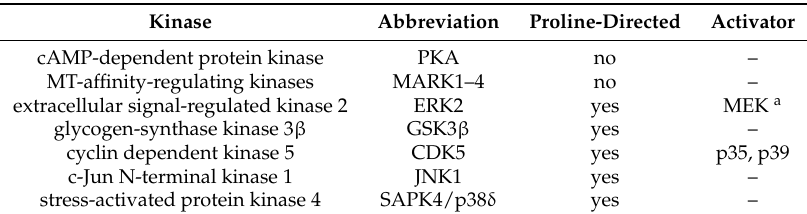
Table 1. List of Ser/Thr kinases discussed in this